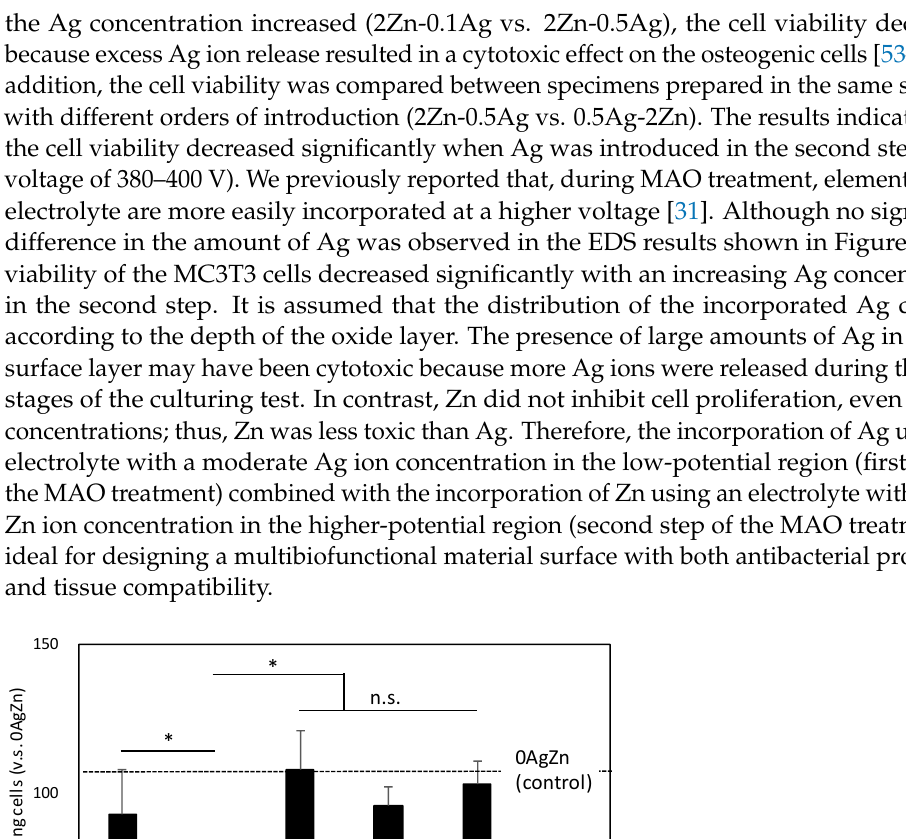
( b ) Figure 7. Amounts of ( a ) Ag and ( b ) Zn in the oxide layer after two months of aging measured via EDS (* statistically significant difference, p < 0.05; n.s.: no significant difference). Measurements were performed on three equally conditioned specimens ( n = 3). The amounts of Ag and Zn ions in the physiological saline used for the aging process were measured via ICP-MS. The solution was refreshed with a new one every week . The concentrations of Ag and Zn ions in the first (0–7 d) and eighth (49–56 d) solutions are shown in Figure 8a,b, respectively. For the ICP-MS measurements, a certain level of signal response was detected as the background, even though the solution contained no